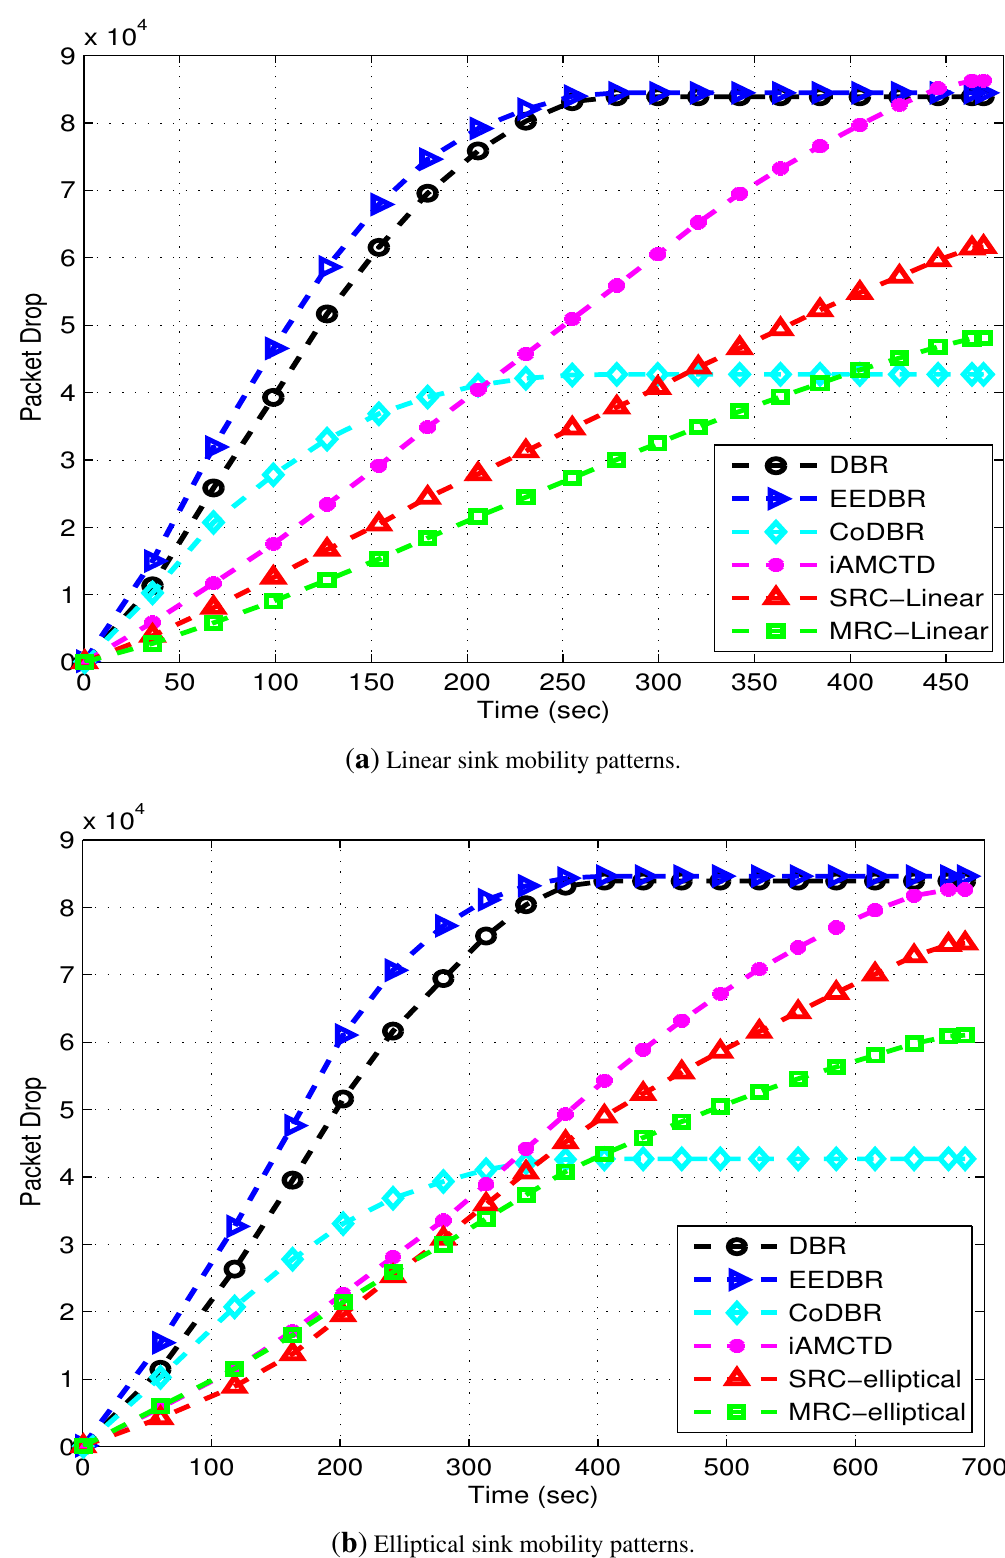
Figure 13. Packet drop attained in the networks with linear and elliptical sink mobility